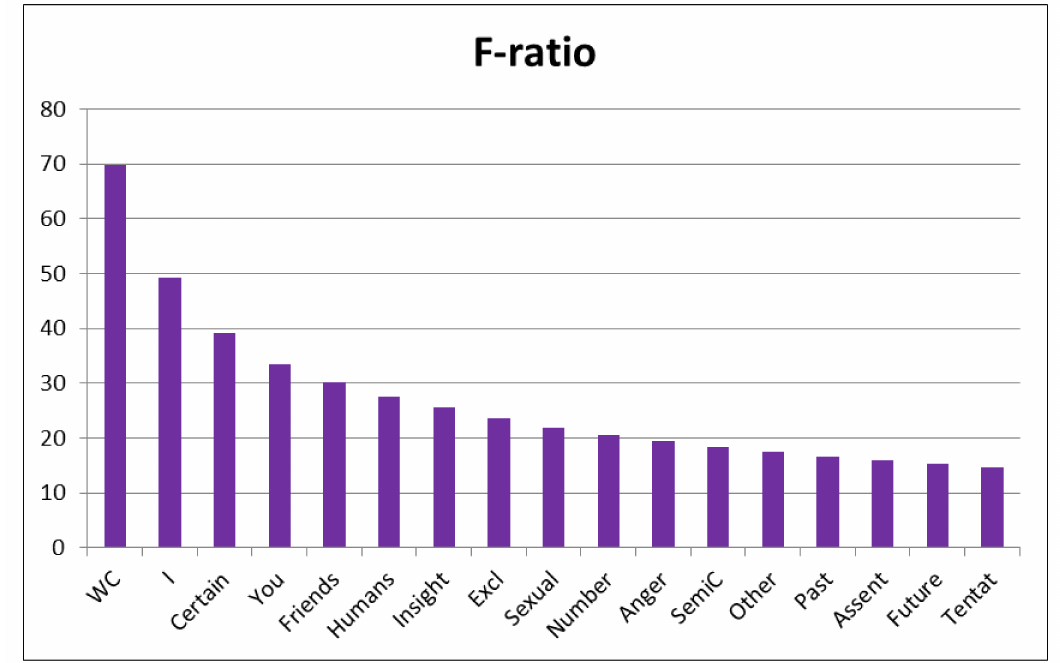
Figure 3. Visual representation of F-ratios from DFA.